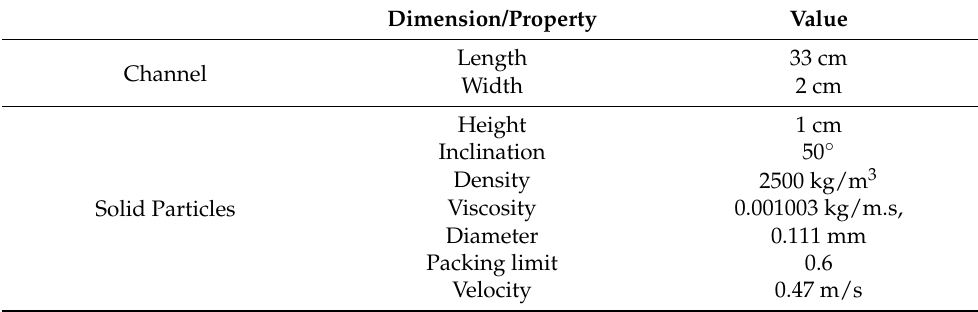
Table 1. Channel and solid particle values.